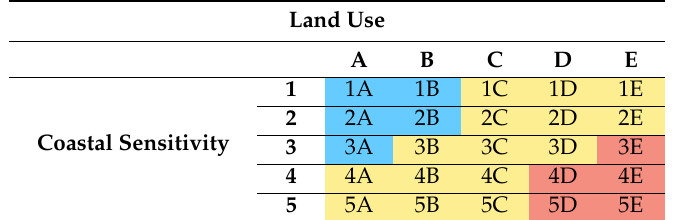
Table 5. Combination of coastal sensitivity and land uses to obtain the response strategies. Blue color corresponds to the “no action” option, yellow corresponds to the “adaptation” option, and red corresponds to the “protection” option.